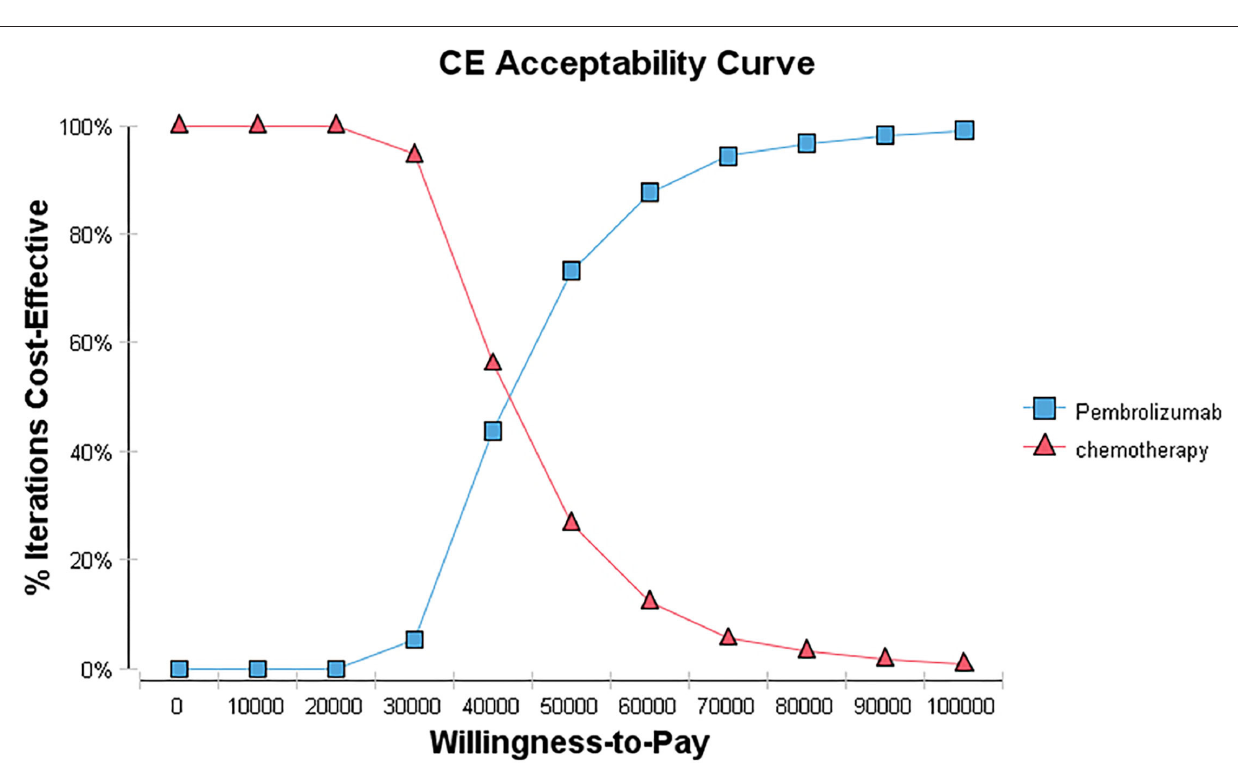
FIGURE 4 | Cost-effectiveness acceptability curve. CE,